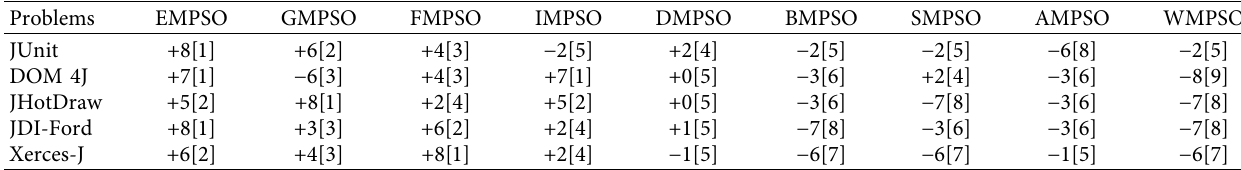
Table 2: Difference [rank] values of each variant in terms of the IGD.